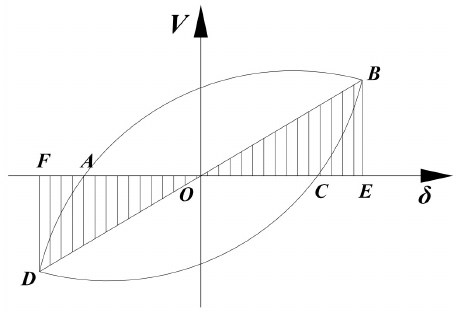
Figure 12. Schematic diagram of hysteresis loop. The relation curve between the equivalent viscous damping coefficient ( h e ) and the load step ( i th) of each member is calculated from Equation (3) and shown in .